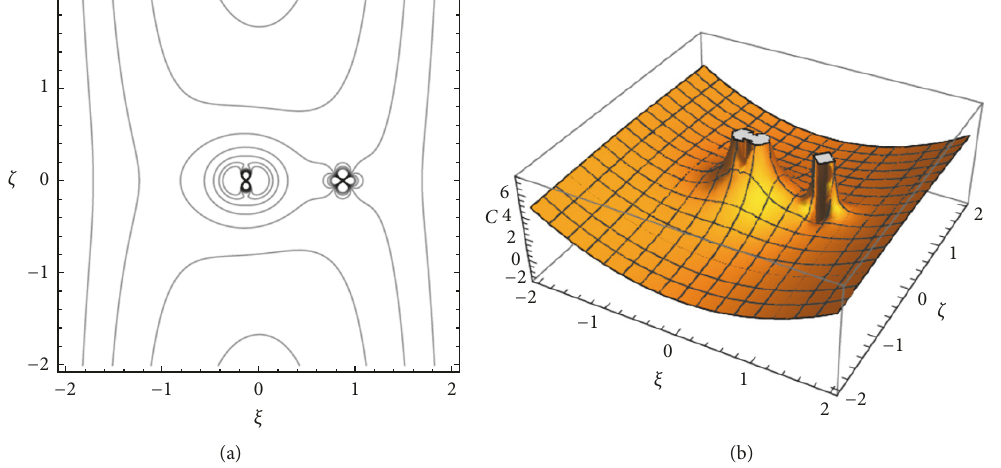
Figure 5: Zero-velocity curves in the ( 𝜉 − 𝜁 ) plane of DP-Leonis for 𝐴 = 0.01,𝑒 = 0.2,𝑎 = 0.95,𝜎 1 = 0.03 and 𝜎 2 = 0.015